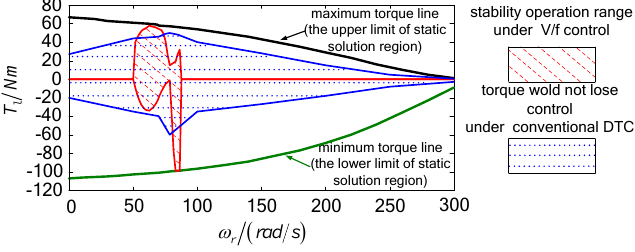
Figure 11. Stability operation ranges under constant V/f control and under conventional DTC.